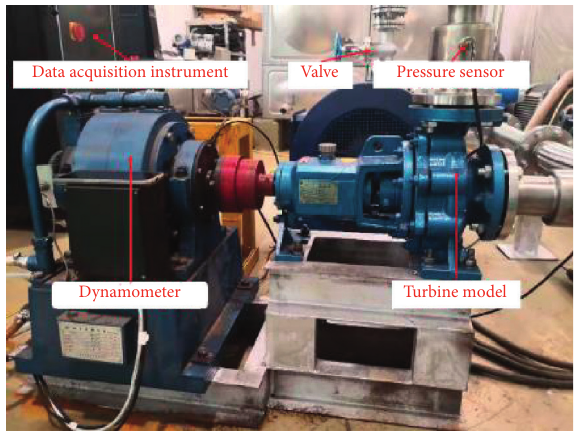
Figure 7: Turbine field